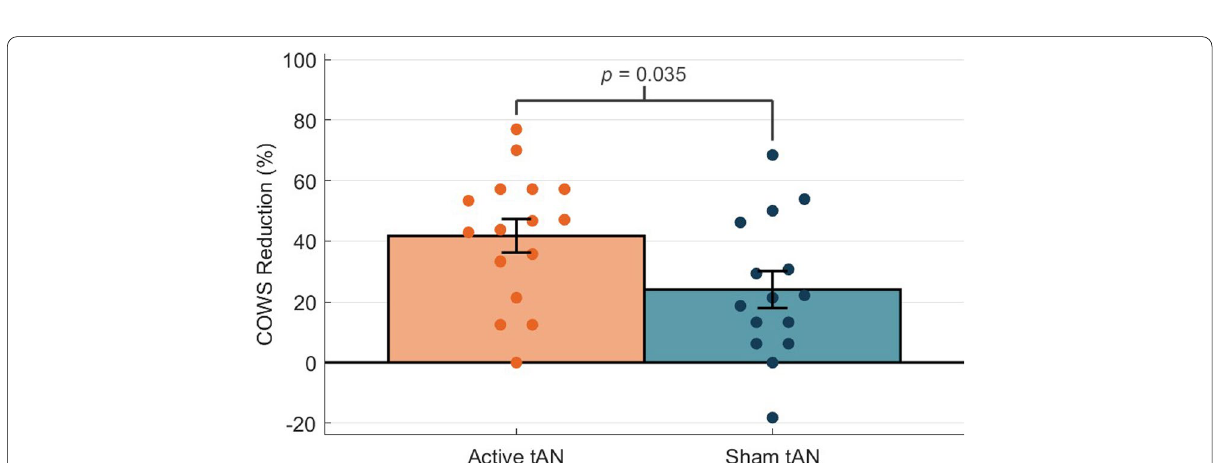
Fig. 5 Comparison of COWS Scores: Active and Sham tAN at the end of the double-blind period. Legend: P -value; Two-sided independent Welch’s t-test; Data representing the intent-to-treat population. Group 1 received active tAN and Group 2 received sham tAN (no stimulation) during this period. Colored dots indicate individual COWS score percent reductions for the respective treatment